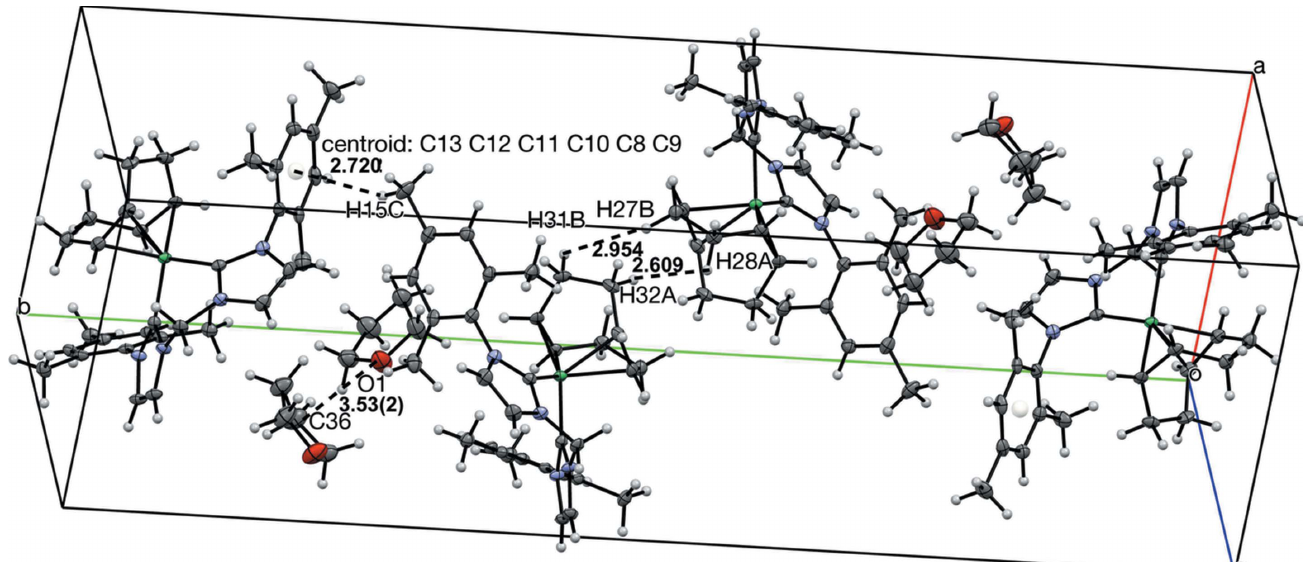
Figure 3 View of four molecules of ( Mes NHC 2 Me)Ni(COD) and THF in the unit cell with 50% probability ellipsoids, highlighting intermolecular distances. Distances between H atoms are listed without standard deviations because the H atoms were positionally